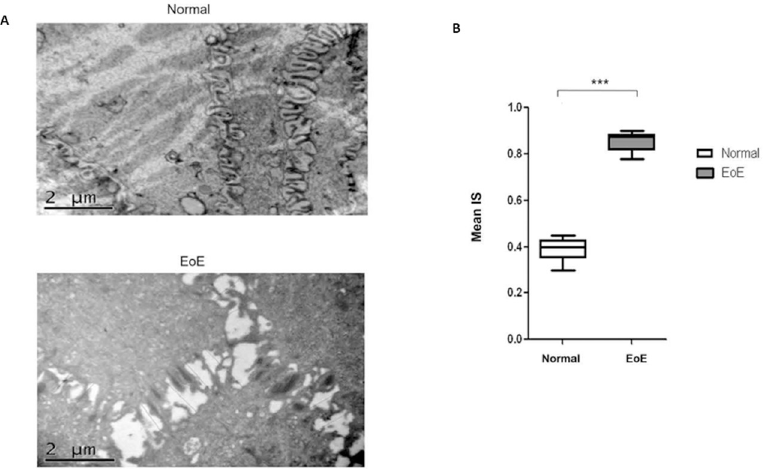
Fig 1. A. TEM images of intercellular space (IS) in esophageal biopsies of Normal (0–5 Eos/HPF) and EoE ( > 15 Eos/ HPF) pediatric patients. Lines perpendicular to membranes indicate areas of measurement. B. Quantification (box plot) shows that IS in EoE is significantly dilated compared to normal (p < 0.001). ��� P < 0.001.